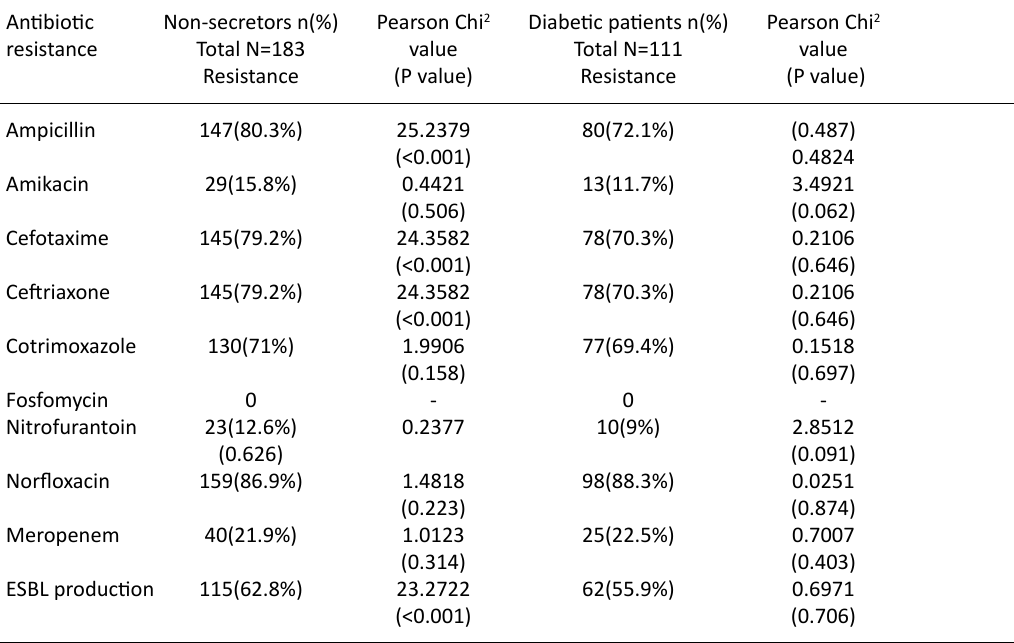
Table 7. Association of Resistance to antibiotics in non-secretor and diabetic patients Antibiotic